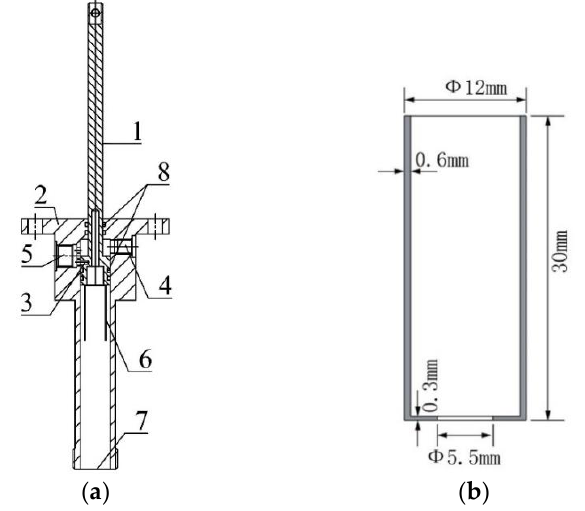
Figure 4. Cross-sectional view of the ( a ) pin puller and ( b ) energy absorbing cup. 1—pin-rod, 2—shell body of pin puller, 3—shear pin, 4—pressure transducer port, 5—cartridge port, 6—energy absorbing cup, 7—cap,